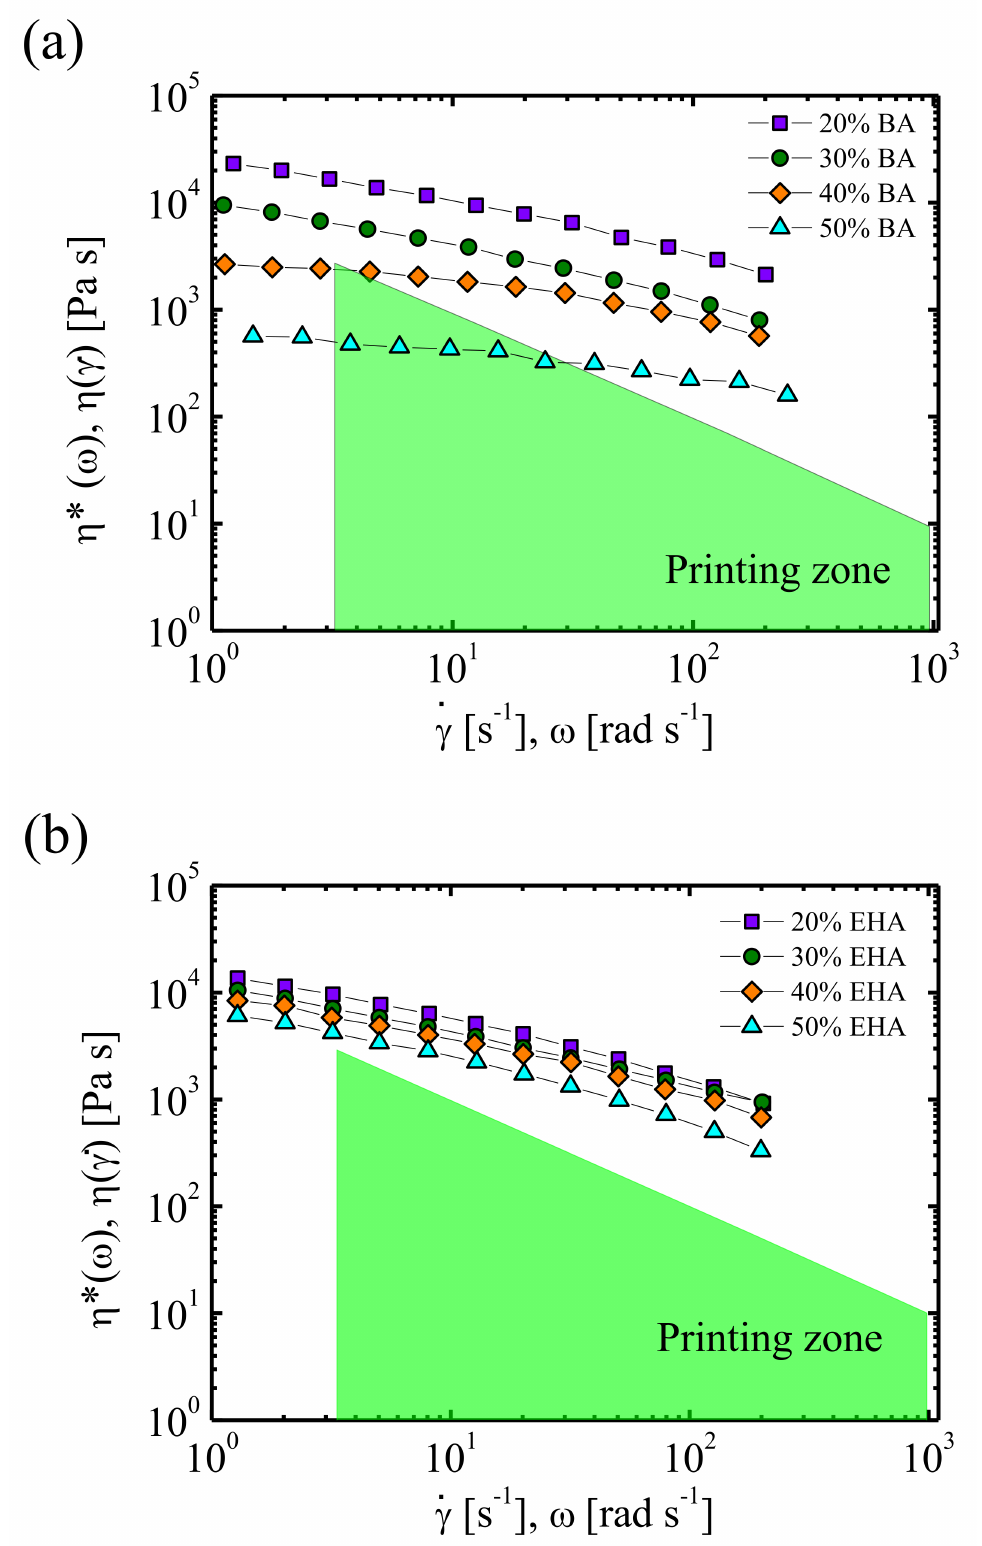
Figure 5. Complex viscosity versus frequency for PVC containing ( a ) poly(vinyl chloride-co-butyl acrylate) (PVC-BA) and ( b ) poly(vinyl chloride-co-2-ethylhexyl acrylate) (PVC-EHA) copolymers [32]. The printing zone is calculated modelling rheological conditions in the nozzle of the 3D printer Reprinted with permission from [32]. Copyright 2018